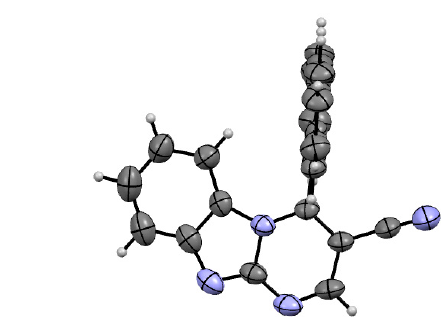
Figure 1. Molecular structure of 6c .